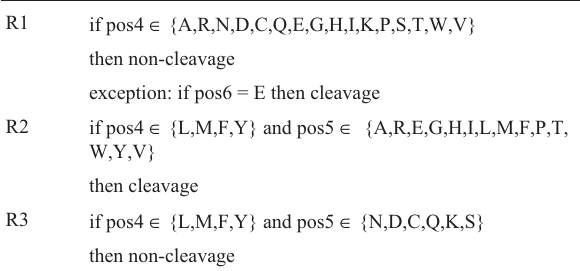
Table 3 - Final hypothesis found using our proposed